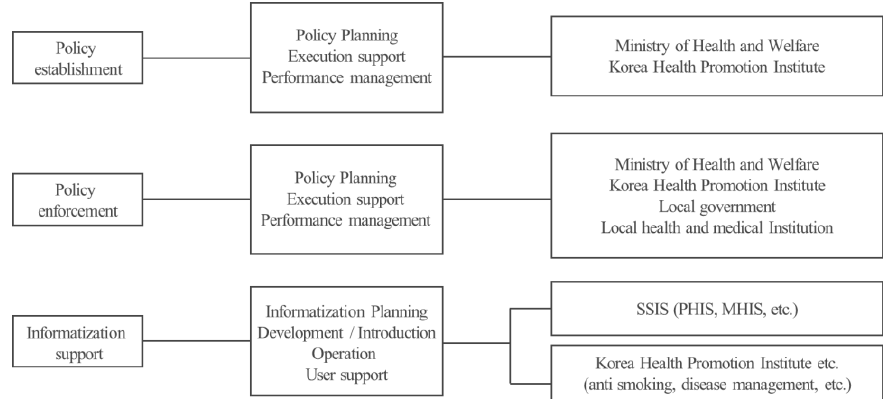
Figure 1. Health promotion projects structure and performance system .